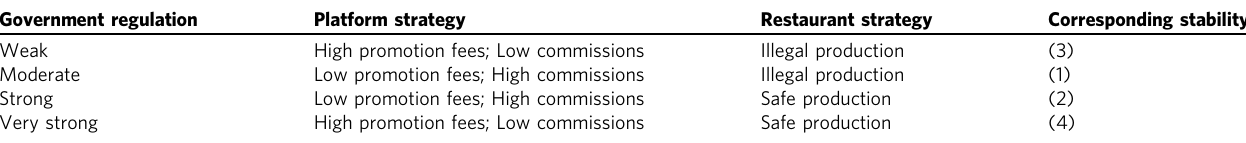
Table 7 Summary of evolutionary mechanisms in Situations (1) – (4).